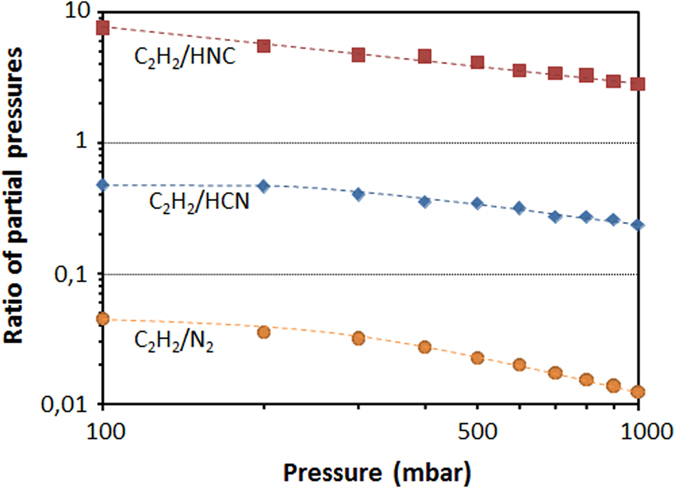
Effect of the growth pressure on the relative amounts of C2H2 over the main three N-containing species N2, HCN and HNC.The curves are extrapolated from the data of23.